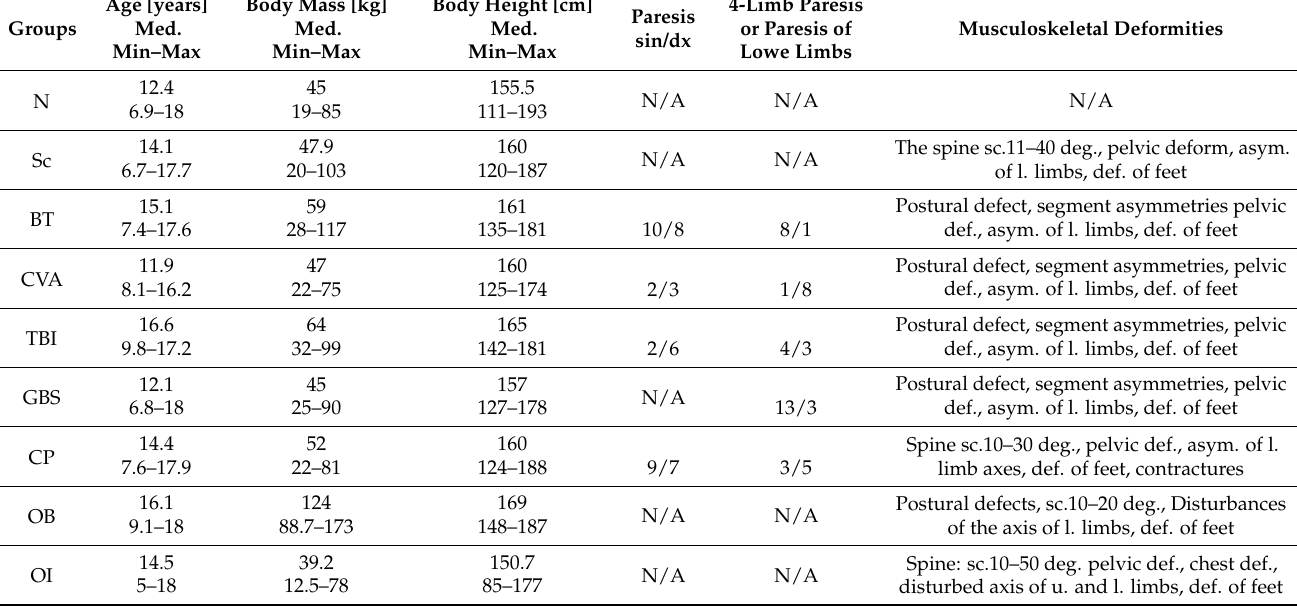
Table 1. Clinical characteristics of the examined